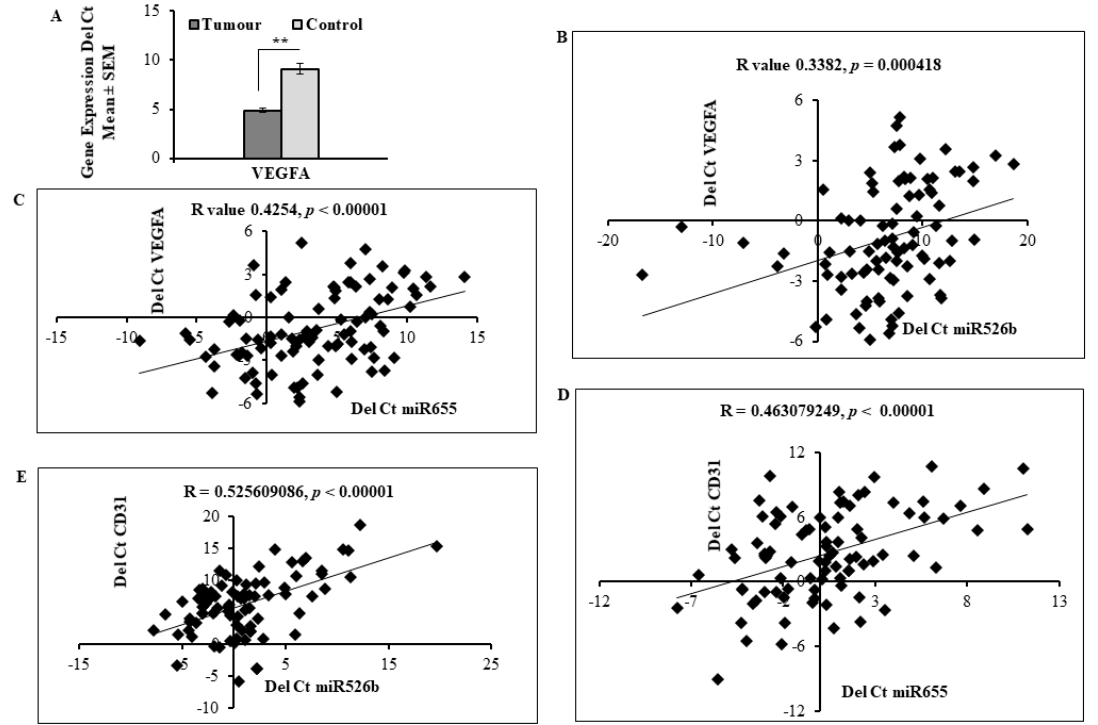
Figure 6. miR526b and miR655 expression is positively correlated with angiogenesis and vascular markers in human breast tumours. ( A ) qRT-PCR analysis of angiogenesis marker VEGFA mRNA expression in control (adjacent non-tumour) and tumoural tissues. Data are represented as mean ± SD. (**) indicates significant differences ( p < 0.01). ( B , C ) miR526b and miR655 expression is positively correlated with VEGFA in primary breast cancer samples; Pearson’s coefficient indicates positive, but moderate correlations. ( D , E ) miR526b and miR655 expression level is positively correlated with CD31 in primary breast cancer samples. Pearson’s coefficient suggests moderate correlation between the two variables. Table 1. Demography, tobacco exposures, tumour grade, and hormone status of the control and tumor samples used in this study. Patient demography of human tissue biopsy samples illustrated.